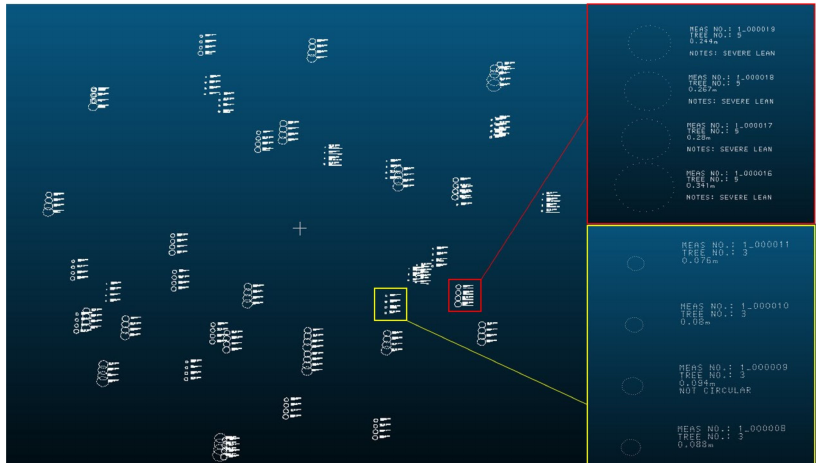
Figure 4. Manual field measurements were visualized as a point cloud so that they could be used to correctly identify the corresponding point cloud slice for each measurement. Field notes such as “Severe lean” and “Not circular” were also shown in the visualization to minimize the risk of incorrectly matching a manual measurement with its corresponding point cloud